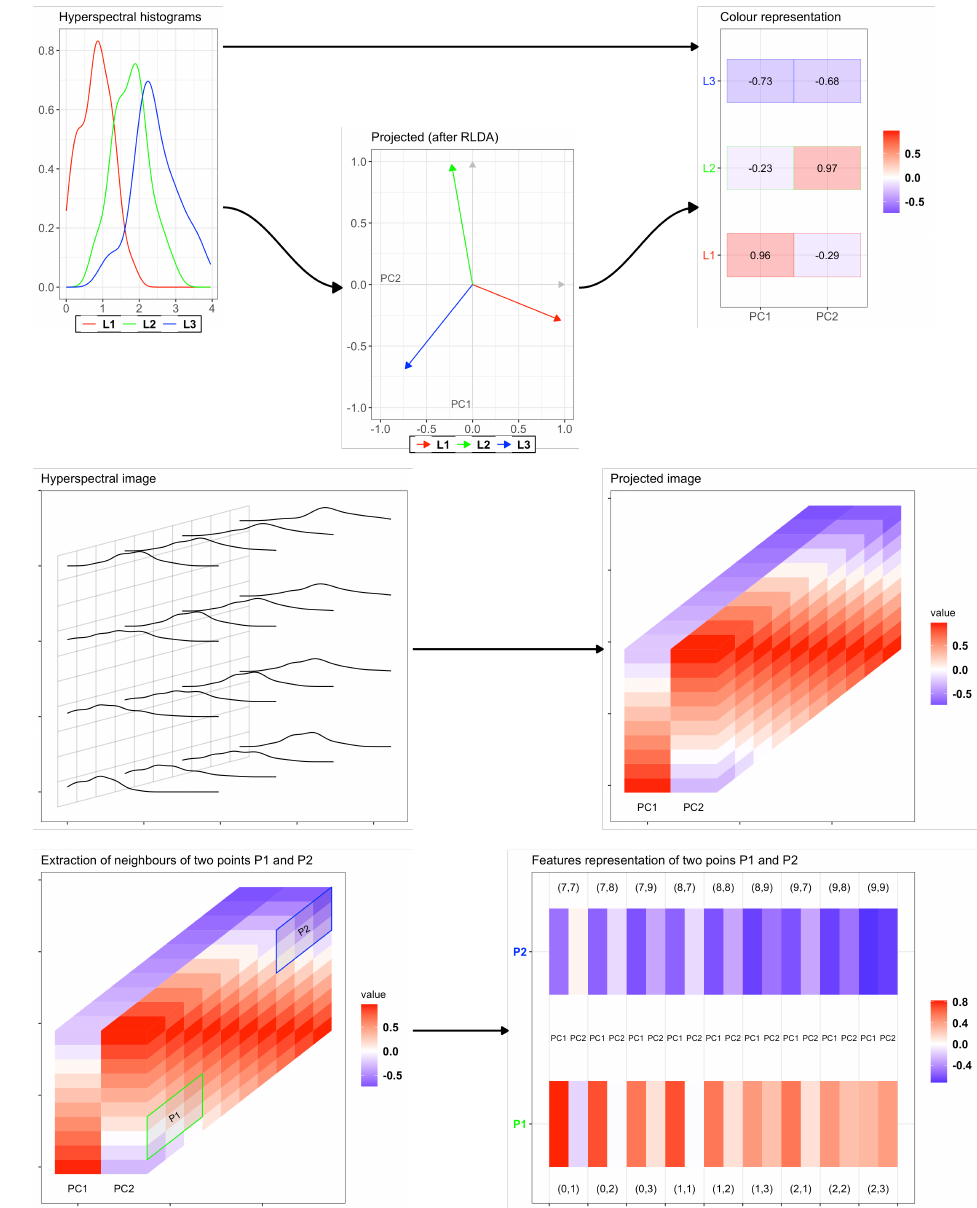
Figure 1. Visual representation of the RLDA algorithm and distance computation of the neighbor- hoods. First row: example with just 3 pixels and their hyperspectral distribution, reduced in their 2D principal components. Second row: RLDA applied to a larger image. Third row: extraction of the 8-neighborhoods of two pixels in each principal